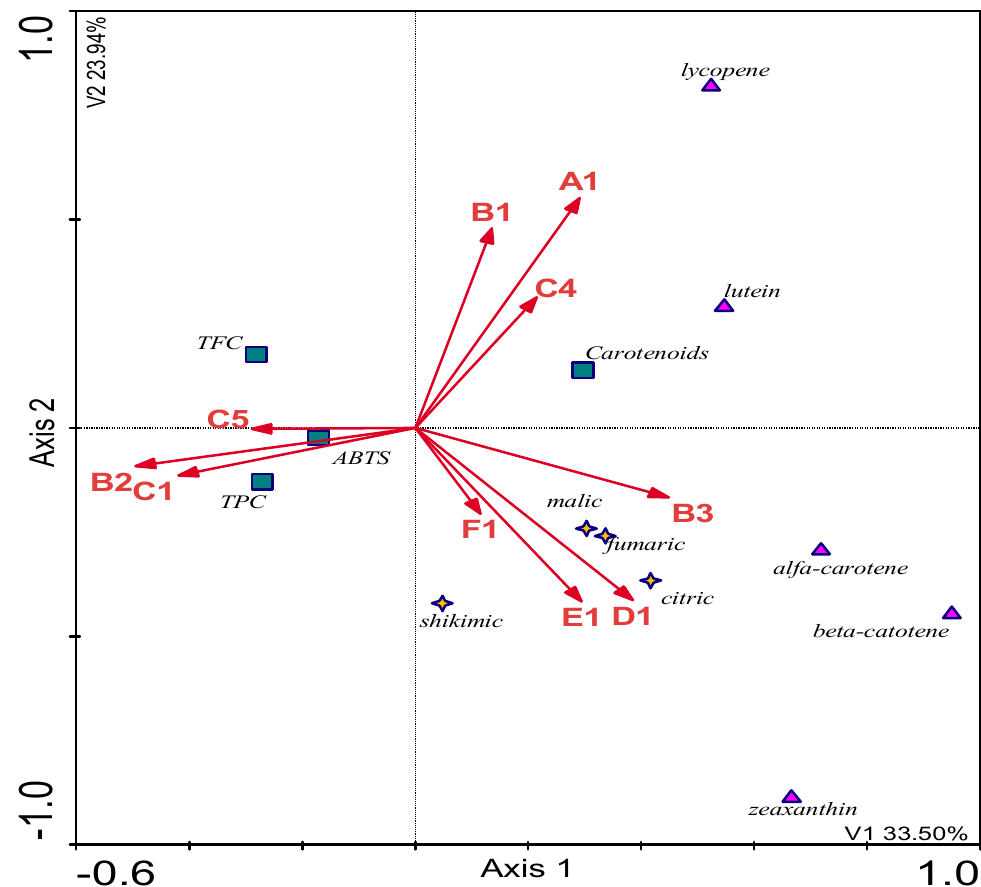
Figure 8. The CCA model. Distribution of the tested compounds (organic acids and carotenoids) in the plant material of the tested species.